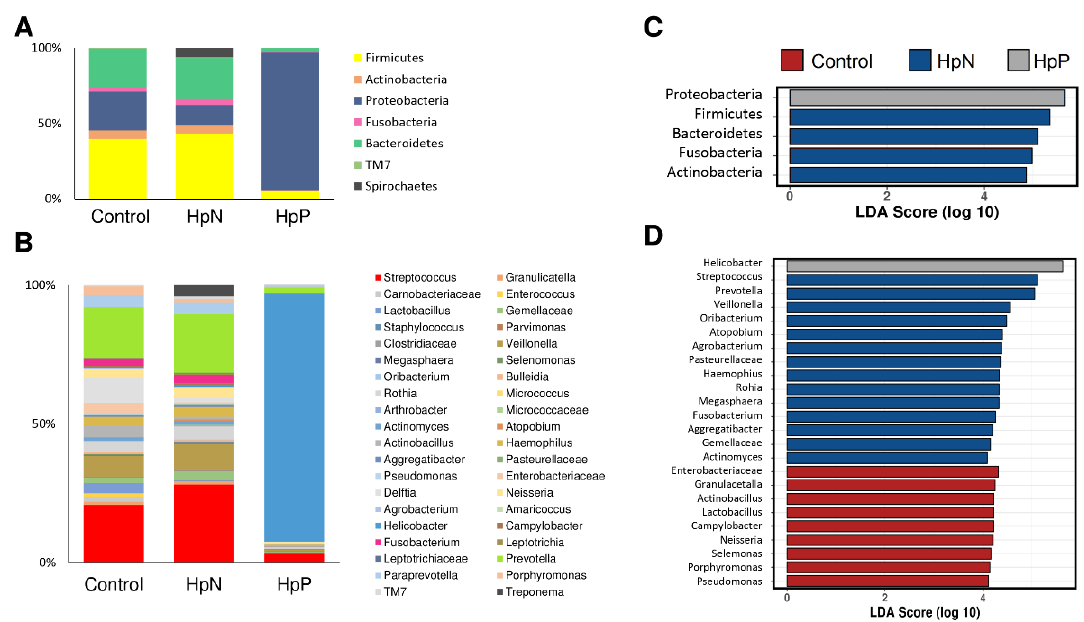
Figure 2. Relative abundance and linear discriminant analysis effect size (LEfSe) by comparison for groups . Microbial relative abundance percentages of the gastric microbiome shown for phylum ( A ) level, genus level ( B ); LEfSe test at phylum level ( C ); at genus level ( D ) are shown according to the HpN, HpP and control groups.